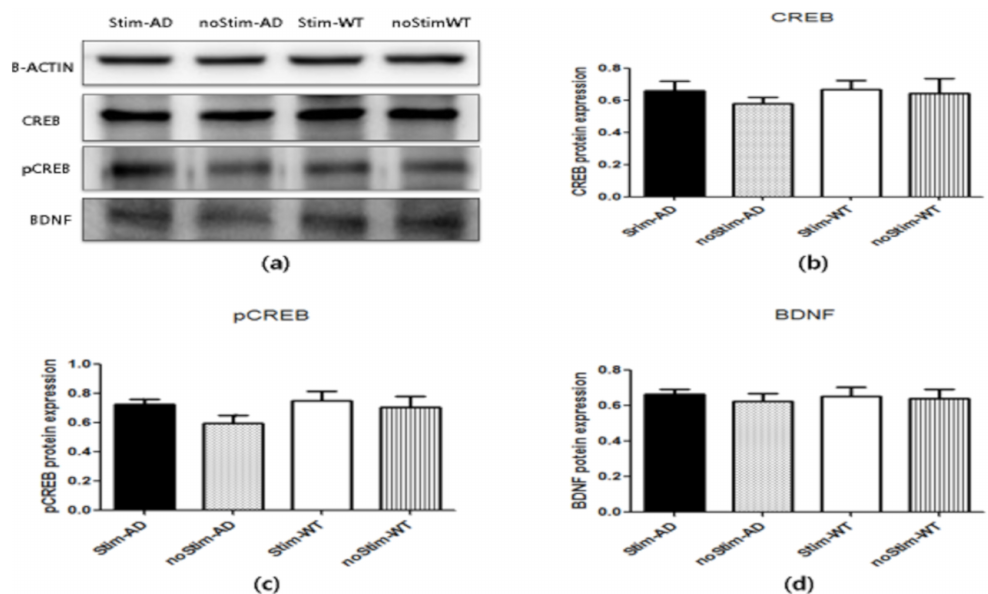
Figure 2. Levels of cyclic amp-response element binding protein (CREB), phosphorylated CREB (pCREB), and Brain-derived neurotrophic factor (BDNF) expression. ( a ) Western blot of the hippocampal samples from each group shows the representative bands of CREB, pCREB, and BDNF. ( b ) The bars represent the quantitative CREB expression levels. ( c ) The bars represent the quantitative pCREB expression levels. ( d ) The bars represent the quantitative BDNF expression levels. Data are presented as mean ± SD and we performed a Kruskal–Wallis test and Tukey’s test using ranks as a post hoc